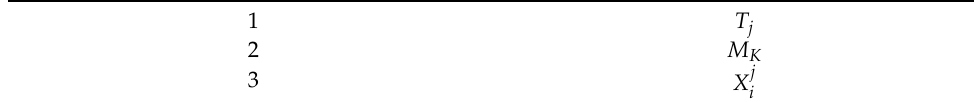
Table 2. The vector of cooperative task allocation for UAVs. 1 T j